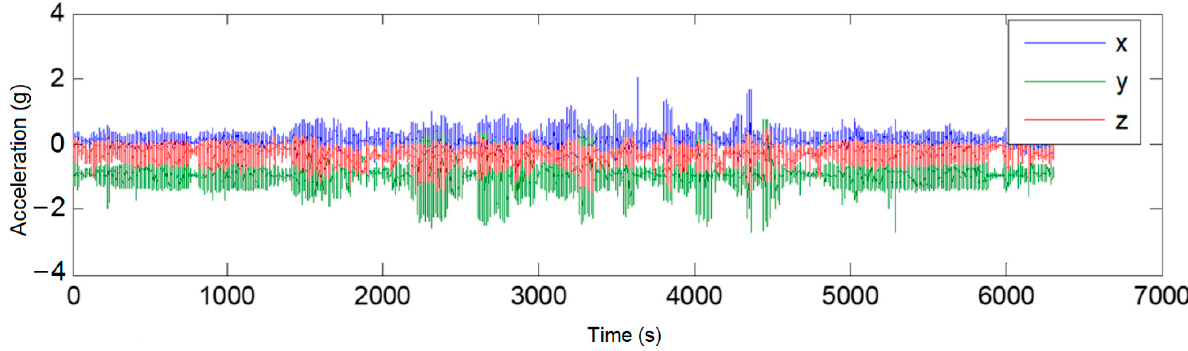
Figure 5. Diagram of low-pass filter.